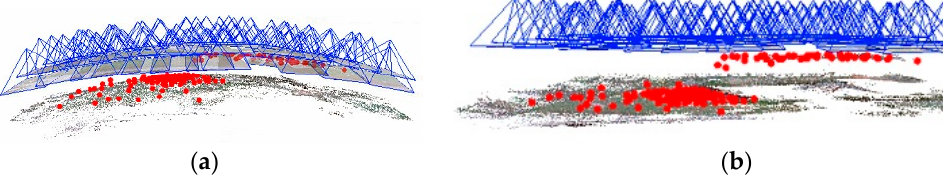
Figure 16. Images and tie points positions for the 23 m nadiral flight after the orientation process using ( a ) SfM method and ( b ) pre ‐ calibration parameters. ( a ) SfM method and ( b ) pre-calibration